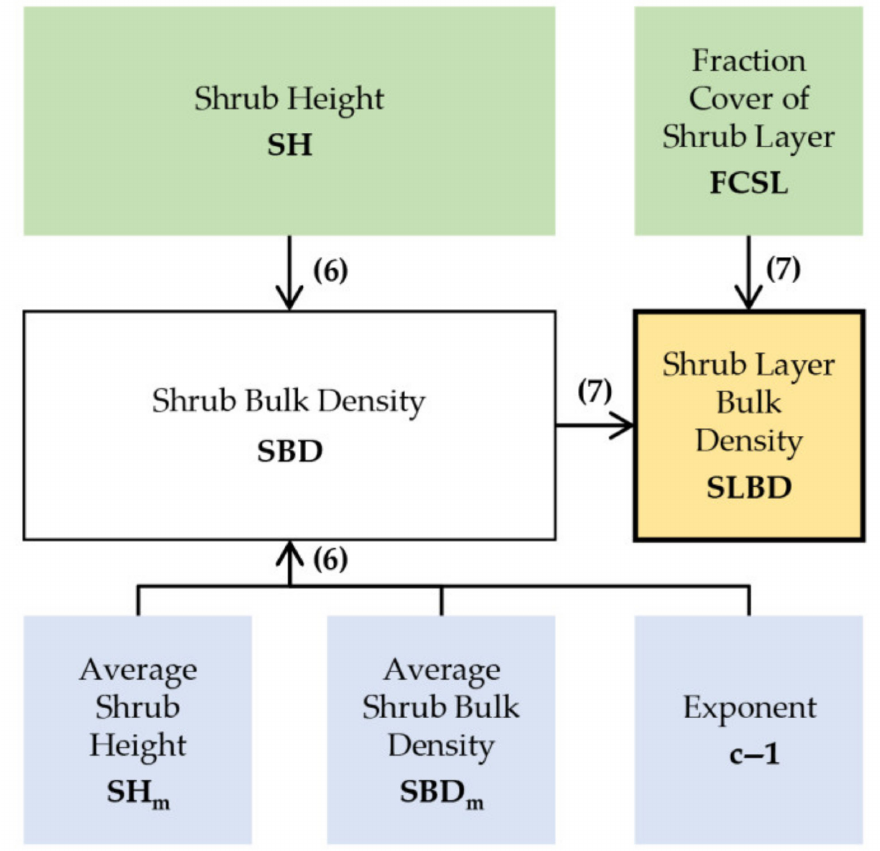
Figure 2. Dependency of Shrub Layer Bulk Density (SLBD) on the different independent variables. Numbers indicate the corresponding equations. Green boxes represent variables from National Forest Inventories. Blue boxes are ancillary variables and parameters from supplementary work estimated for each shrub type. White boxes are intermediate results. The yellow box represents the final output for fire behavior